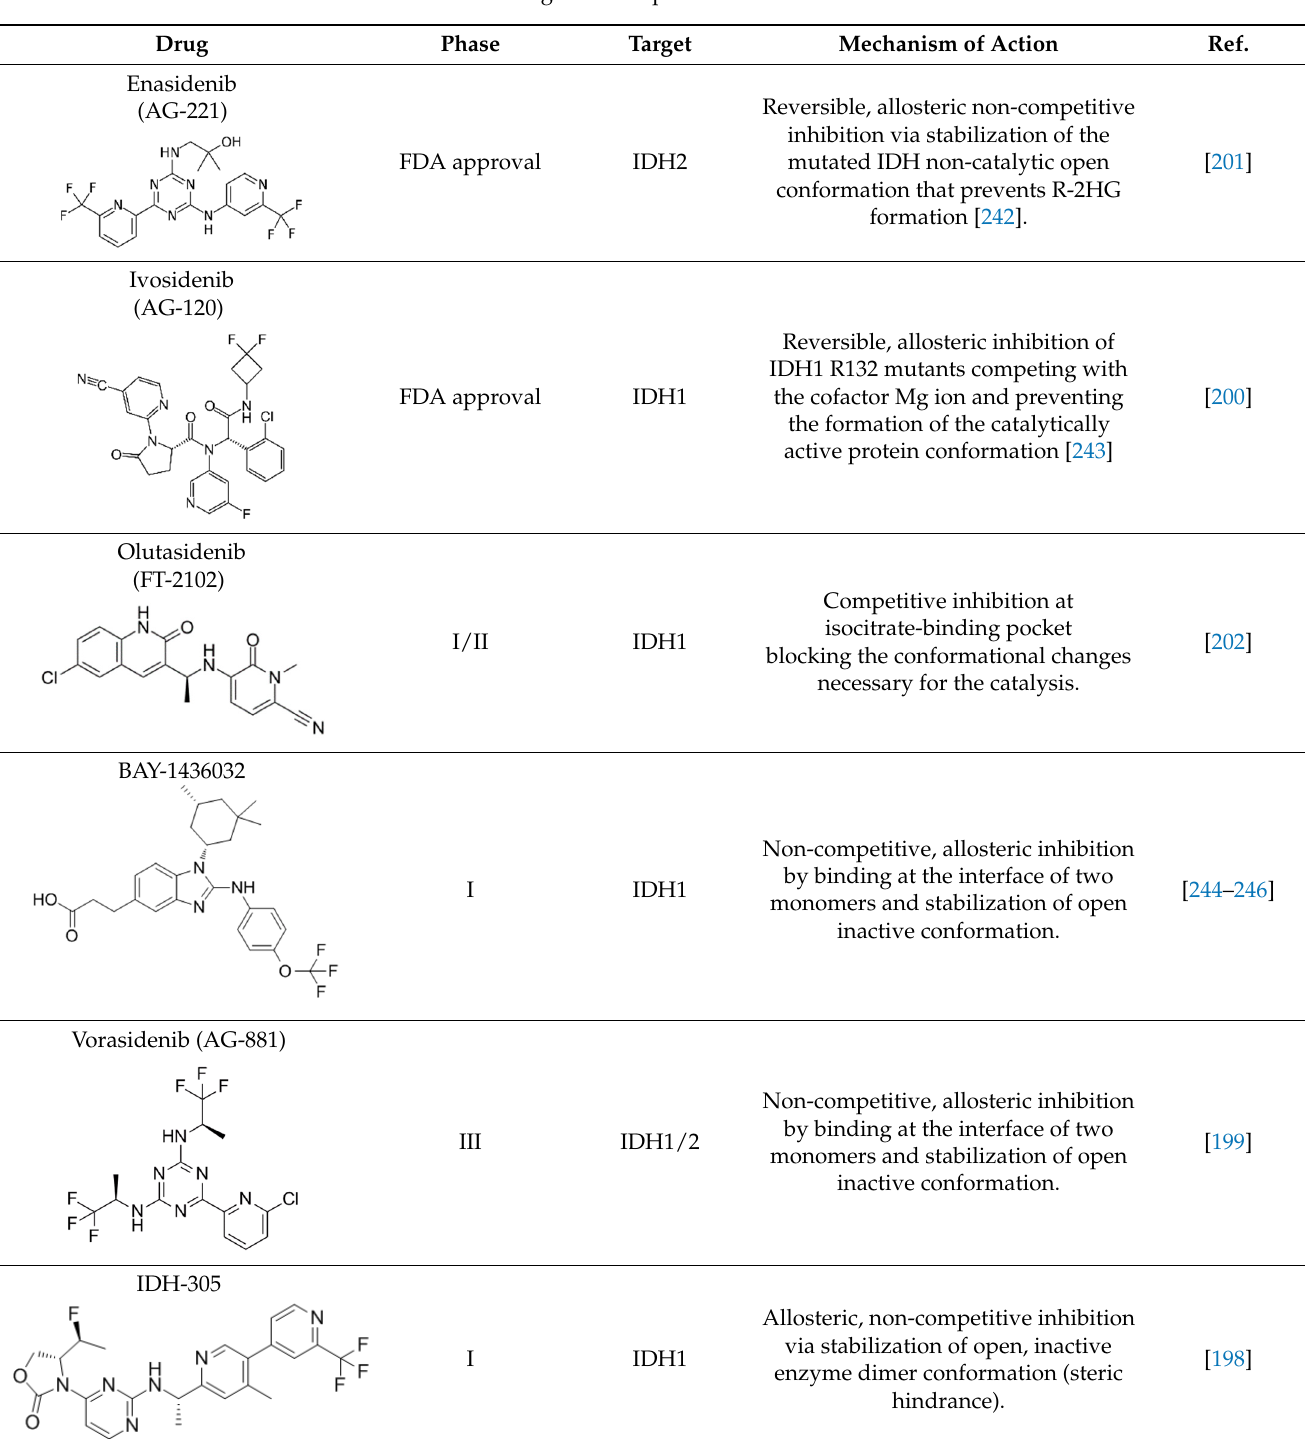
Table 1. Targeted therapies for IDH mutation.